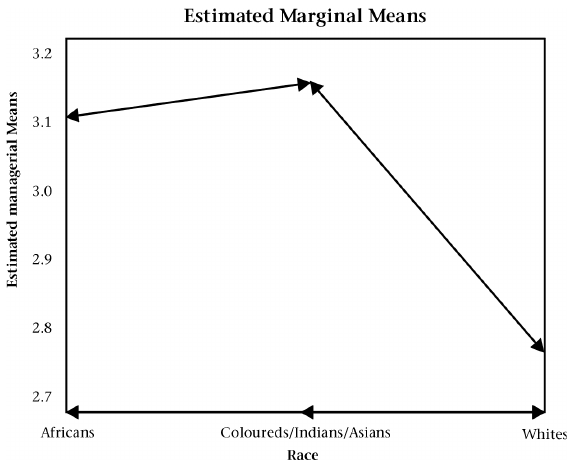
Figure 4:Biographical variable: Race as predictor of the perception of employment equity